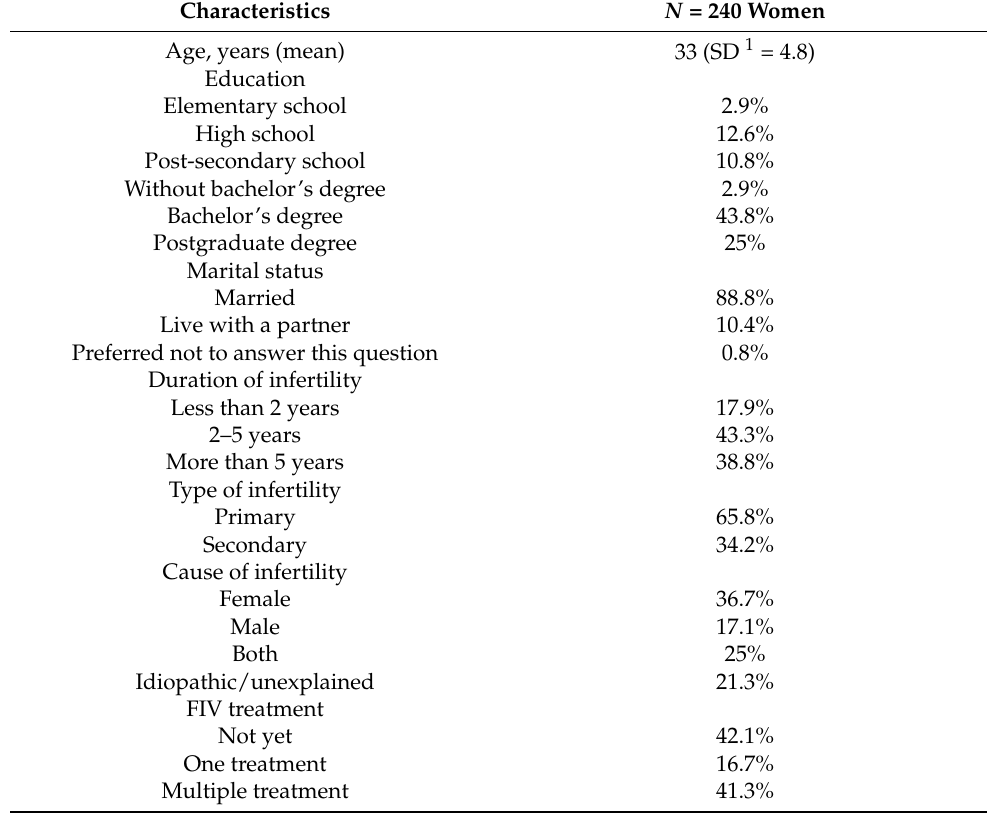
Table 1. Demographic and fertility characteristics of the infertile